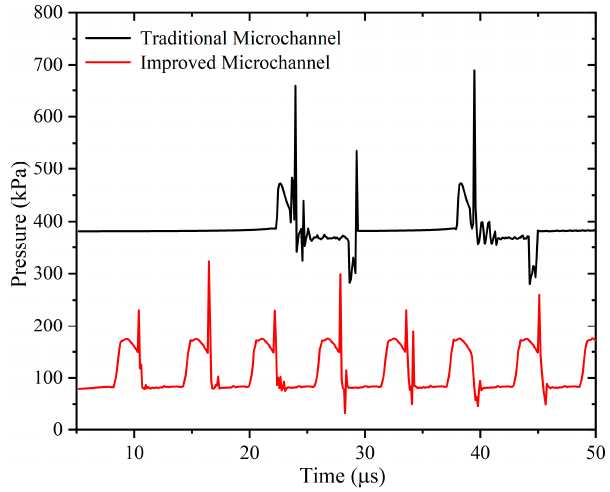
Figure 13. Variation of pressure at p-point with time in traditional and improved microchannels.